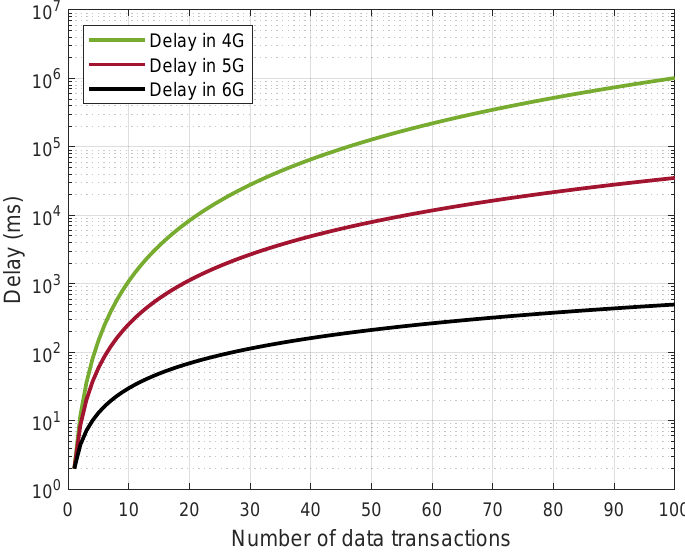
Figure 6. Comparison of latency with traditional network